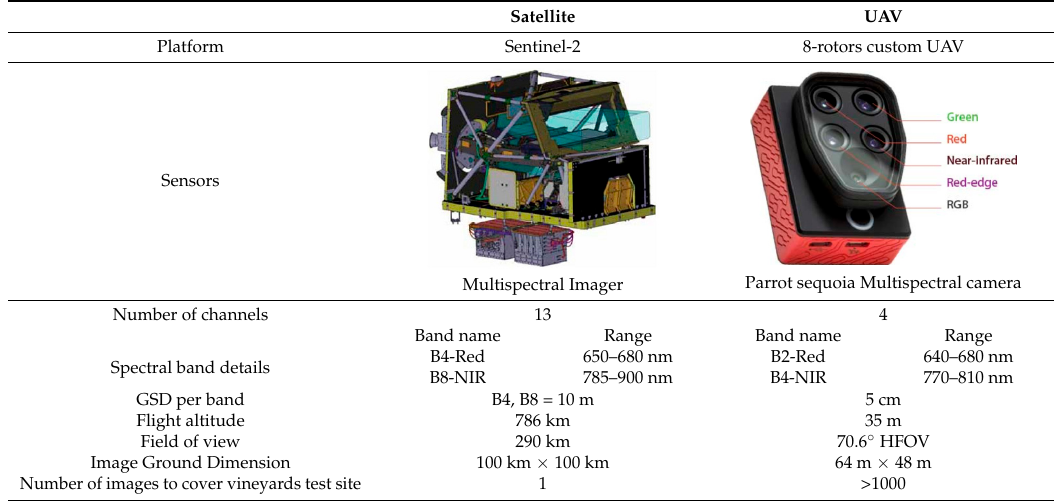
Table 1. Technical details of the considered and adopted platforms and sensors.